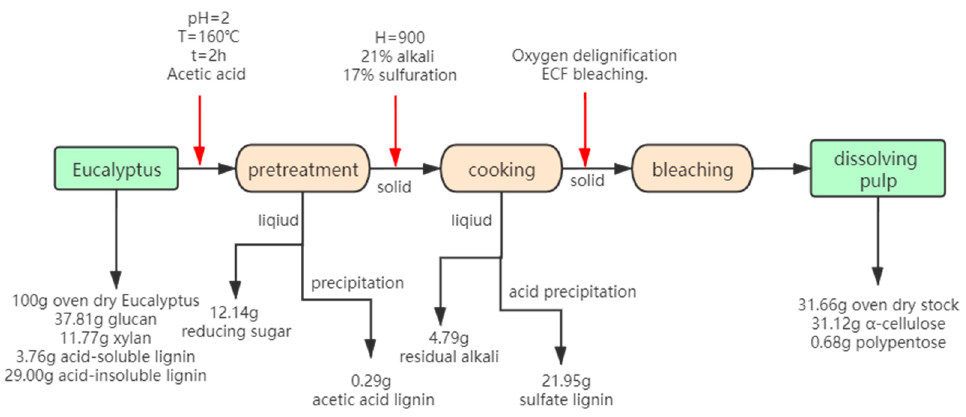
Figure 5. Flow chart of full utilization of biomass after pre-acetic acid.